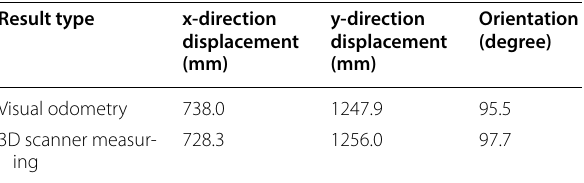
Table 2 Comparing results of visual odometry and